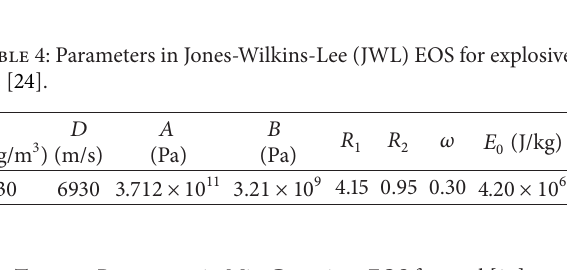
Table 5: Parameters in Mie-Gruneisen EOS for steel [25]. 𝜌 3 ) 0 (kg/m